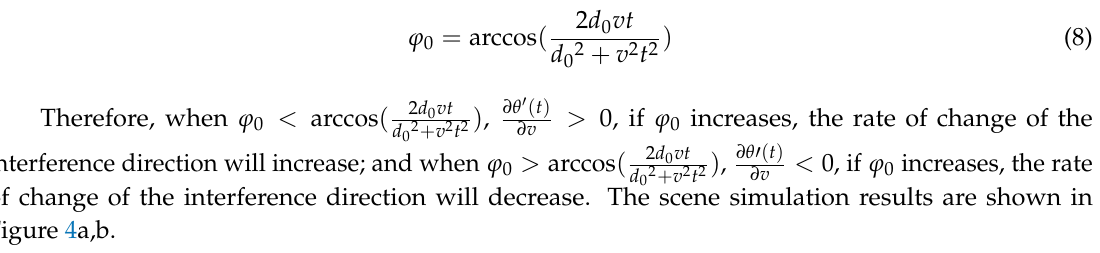
. ( a ) The change of the 0